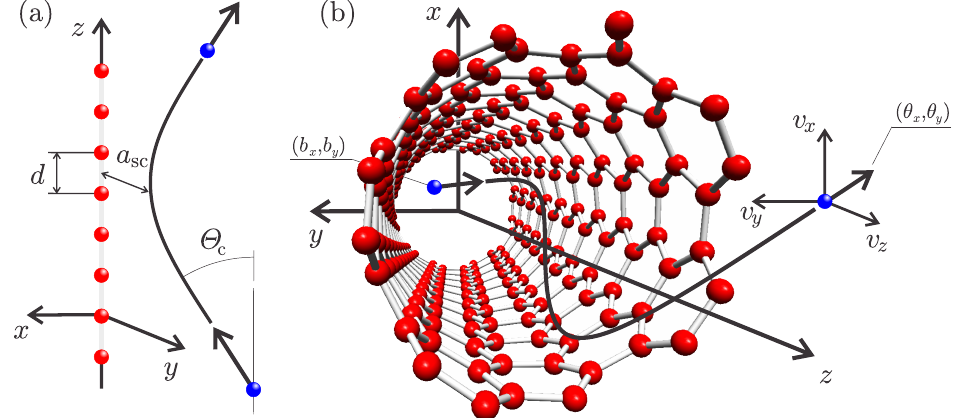
Figure 2. ( a ) Schematic representation of the ion Scattering by the atomic string. The interatomic distance of the string is d . The maximal ion incident angle Θ c and its minimal approach distance a sc are indicated ( b ) Schematic representation of the ion channeling process. The deflection angles ( θ x , θ y ) at the exit of the SWCNT are smaller than the critical